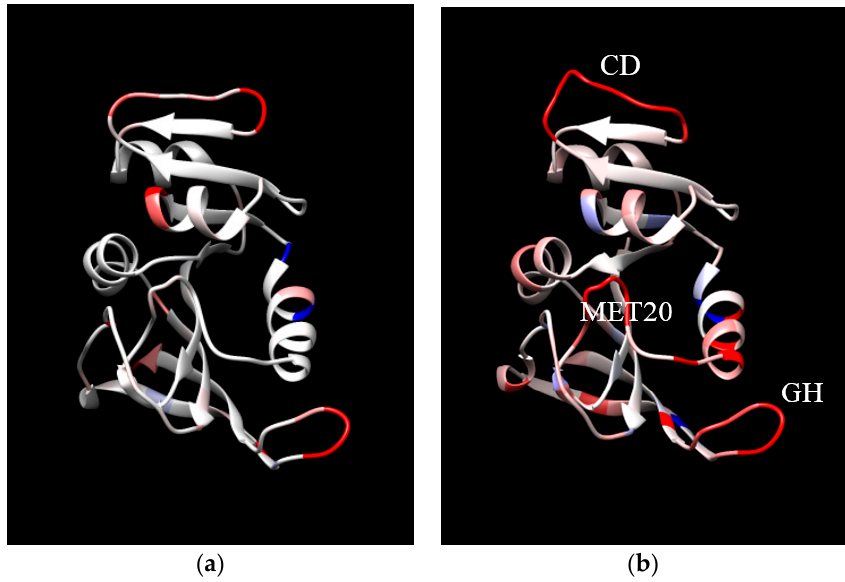
Figure 3. The difference in mean square fluctuations (MSF) between 279 and 310 K at 1 bar for ( a ) EcDHFR and ( b ) MpDHFR. The coloring of each residue indicates the difference in the average MSF of all heavy atoms in the residue, where the coloring scale is that –0.5 is dark blue, 0 is white, and 2.0 is dark red. Loops are identified in ( b ).